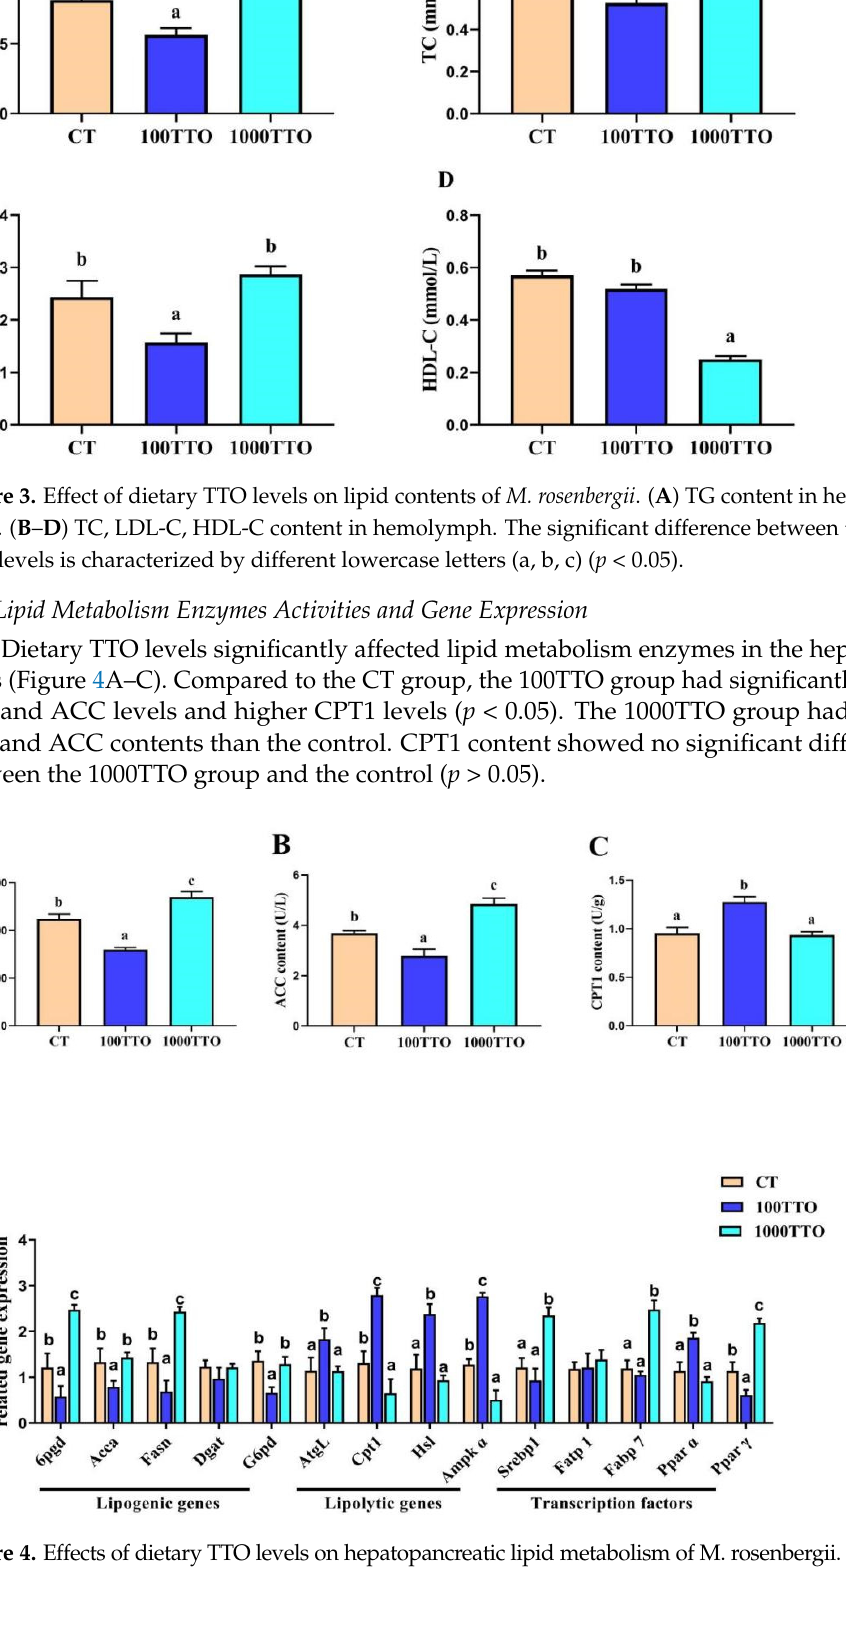
Figure 3. Effect of dietary TTO levels on lipid contents of M. rosenbergii . ( A ) TG content in hepato ‐ pancreas. ( B – D ) TC, LDL ‐ C, HDL ‐ C content in hemolymph. The significant difference between the three TTO levels is characterized by different lowercase letters (a, b, c) ( p < 0.05).